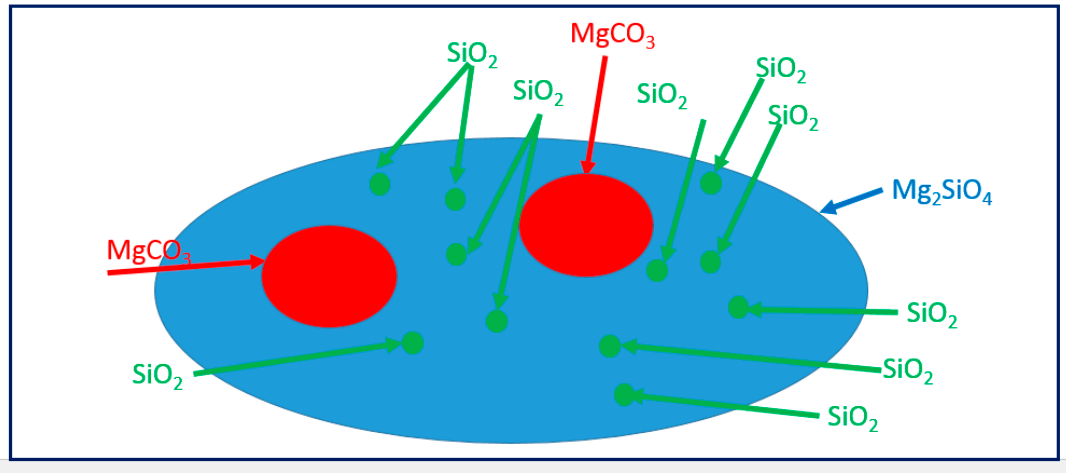
Figure 12. The proposed schematic model for the formation of SiO 2 from Mg 2 SiO 4 in an autoclave.